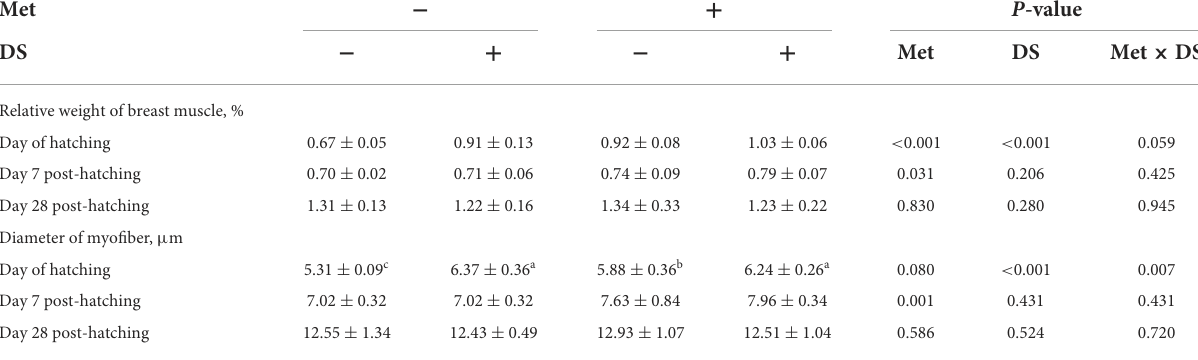
TABLE 4 Effects of in ovo injection of methionine (Met) and disaccharide (DS) on breast muscle parameters of geese during the early-life post-hatching 1,2 . Met